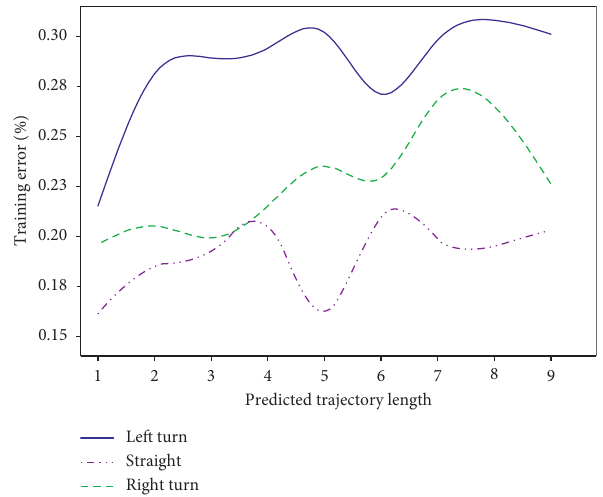
Figure 9: Relationship between the prediction step size and the training mean square